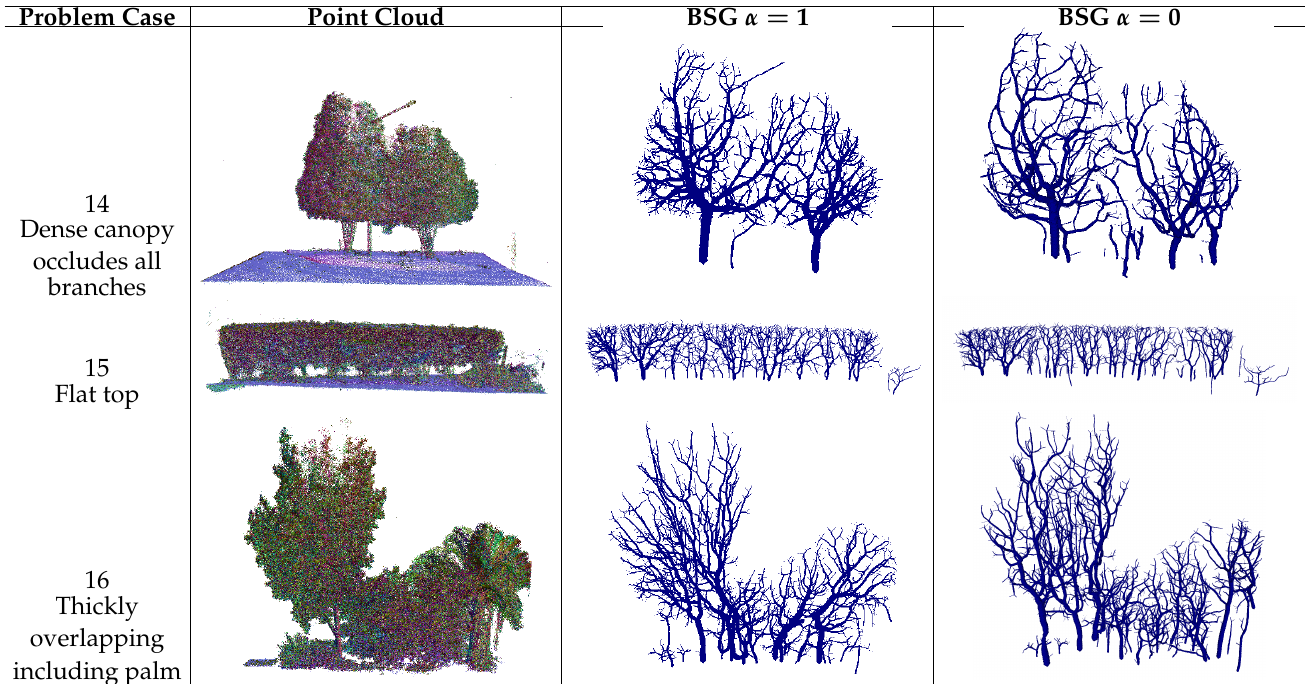
Table 4. Ablation study: comparing results for two values of the branch angle parameter α on dense foliage that heavily restricts branch